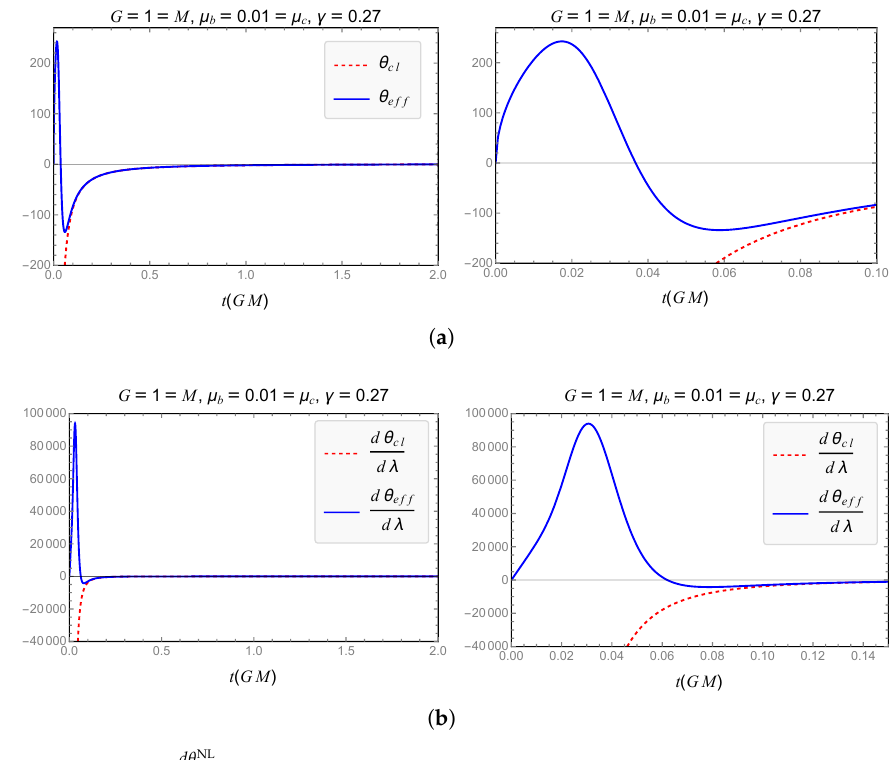
d θ NL ( ˚ µ ) Figure 5. θ NL and . ( a ) Left: Classical vs. null θ in the ˚ µ scheme as a function of the Schwarzschild ( ˚ µ ) d λ time t . The effective expansion θ NL goes to zero as t → 0. Right: Close up of the left figure close to ( ˚ µ ) t = 0. ( b ) Left: Classical vs. null d θ in the ˚ µ scheme as a function of the Schwarzschild time t . The d λ d θ NL ( ˚ µ ) goes to zero as t → 0. Right: Close up of the left figure close to t = effective d λ